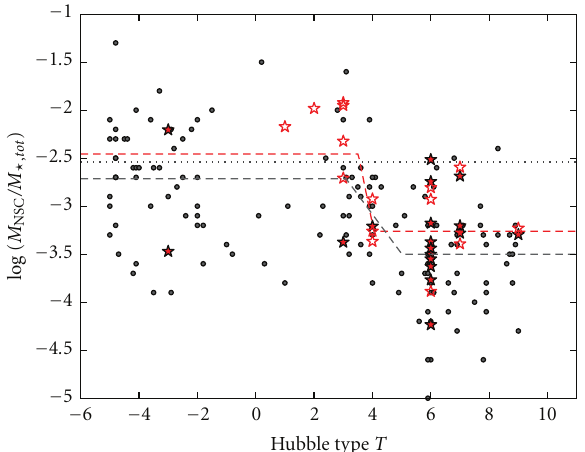
Figure 4: Relative masses of NSCs versus Hubble type of host galaxy, based on the compilation of Seth et al. [48]. Filled gray circles are NSC masses estimated from broadband colors or assumed M/L ratios by Seth et al [29]; red stars indicate NSC masses from spectroscopic (hollow) or dynamical (filled) measurements (see Table 2 for references). Also shown are simple fits to the dynamical+spectroscopic masses (dashed red line) and to the entire sample (dashed gray line), along with the mean mass ratio of SMBHs relative to their host bulges (dotted gray